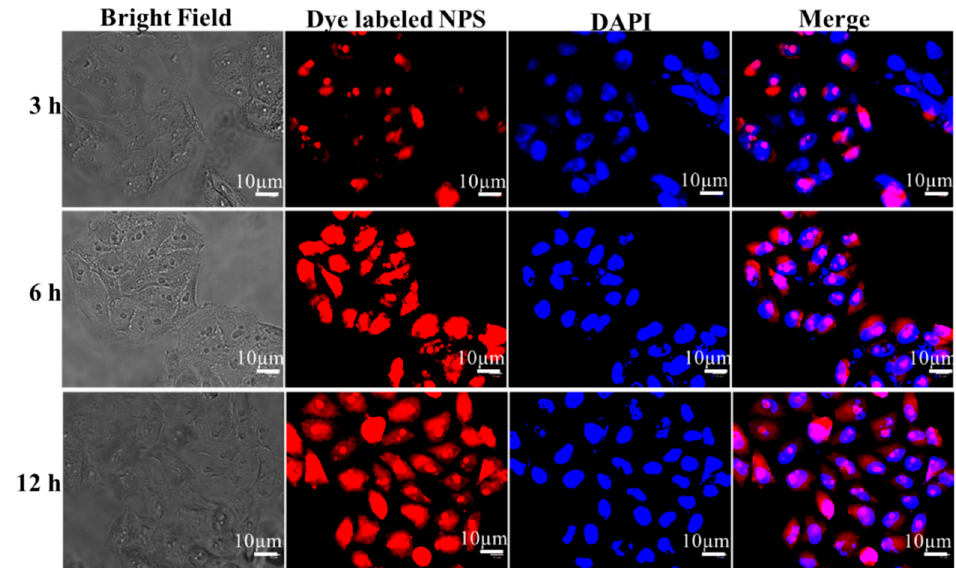
Figure 8. Cellular uptake of prodrug nanoparticles. The fluorescence intensity measuring Rhodamine B-labeled Hep–Chl uptake after 3, 6, and 12 h of treatment of HeLa cells.